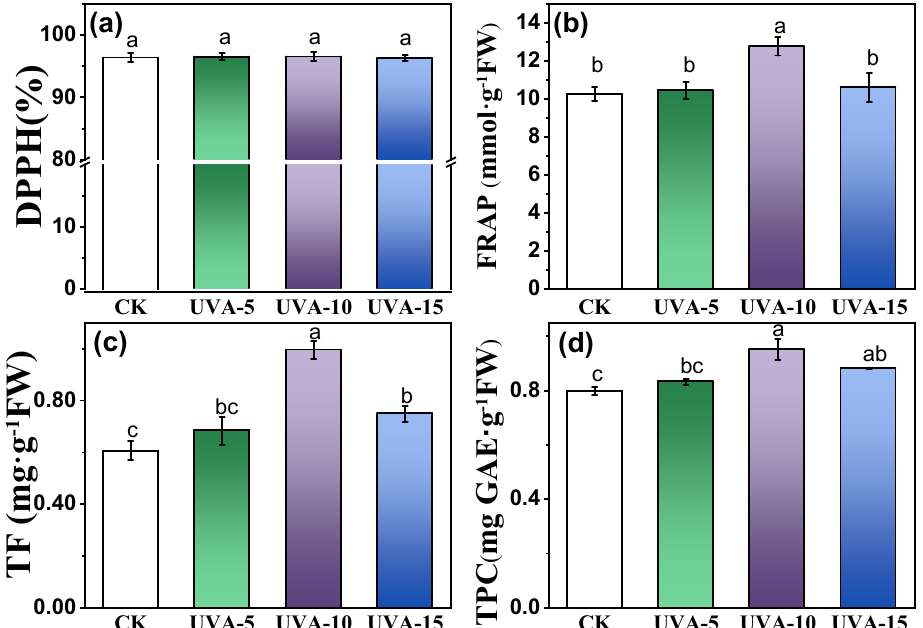
Figure 5. Antioxidant content and capacity of Chinese kale baby-leaves under different supplemental UV-A intensity. ( a ) DPPH = 2,2-diphenyl-1-picrylhydrazyl, ( b ) FRAP = ferric-reducing antioxidant power, ( c ) TF = total flavonoid, ( d ) TPC = total phenolics. The results presented were means ± standard error ( n = 3). Different letters ( a – d ) upon the bar plots indicate significant difference at p < 0.05 using one-way analysis of variance with Duncan’s multiple-range test.